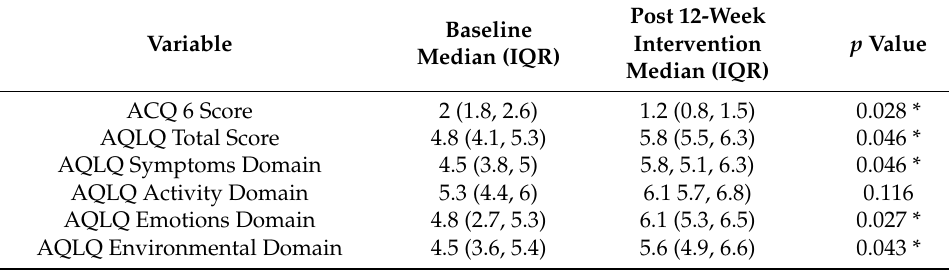
Table 3. Symptom scores and quality of life scores between baseline and week 12.